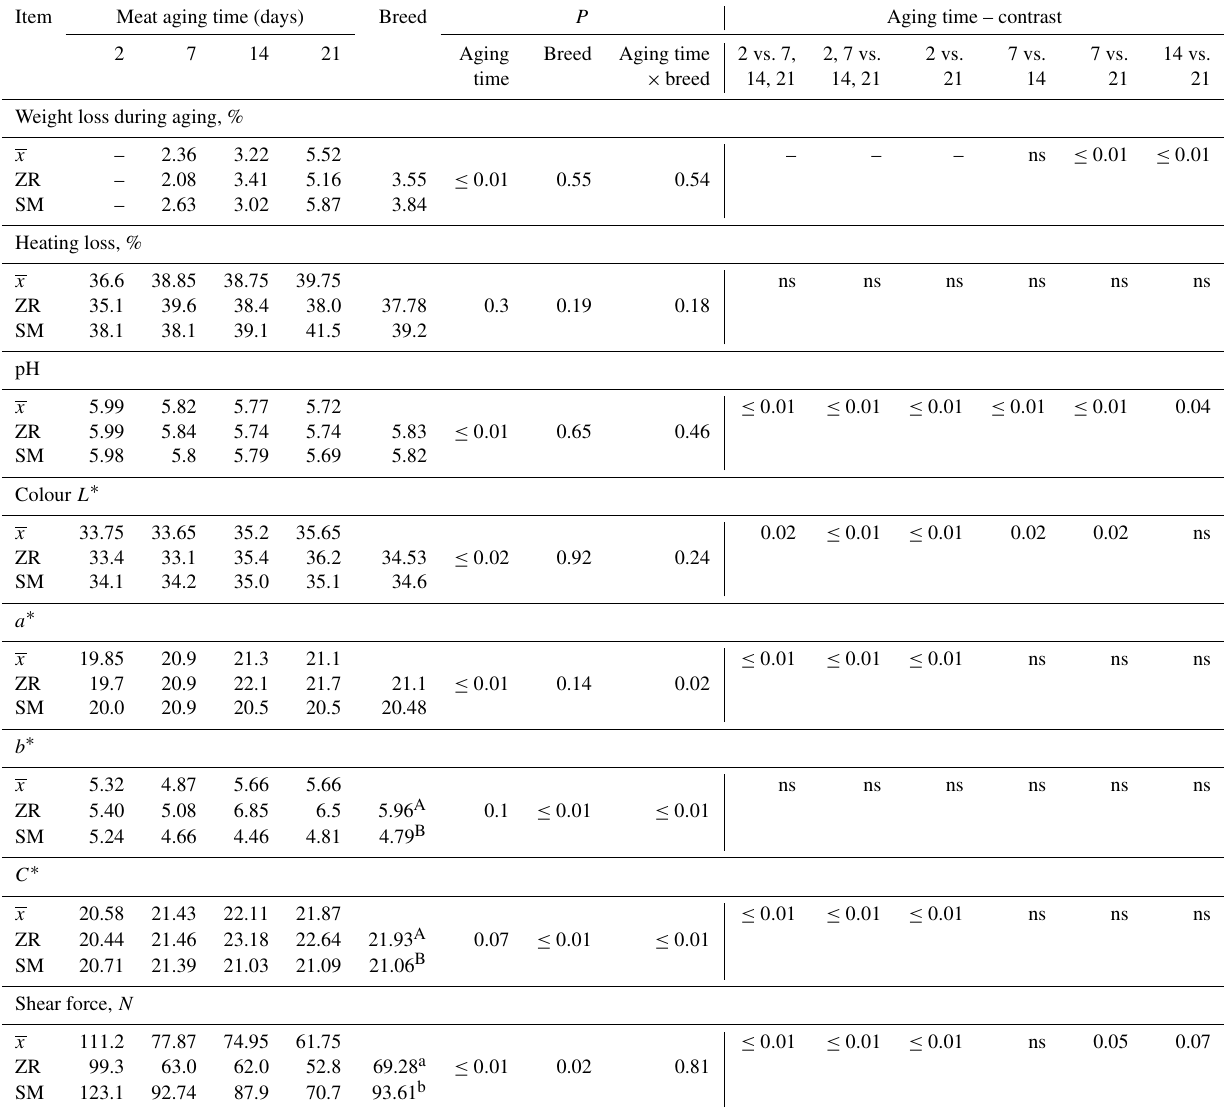
Table 1. Effect of breed on physicochemical characteristics of meat during aging. Item Meat aging time